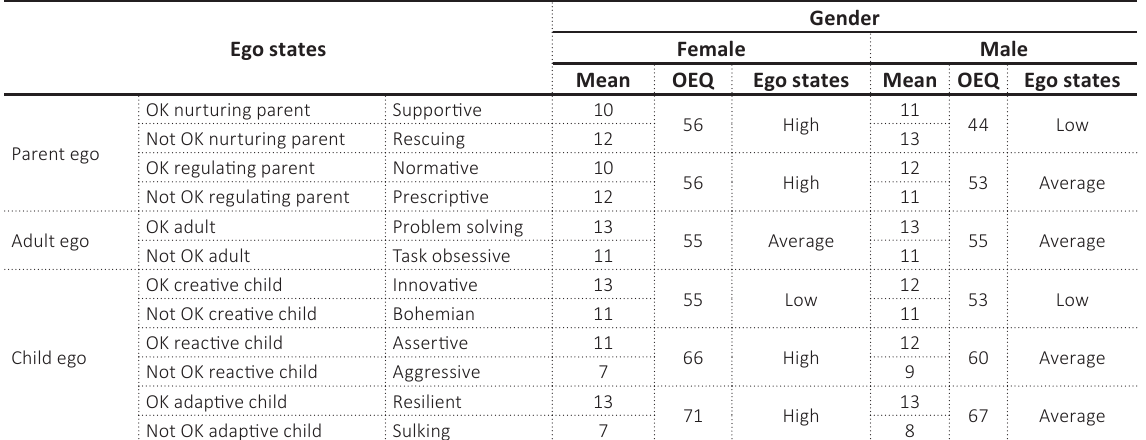
Table 2. Level of ego states based on gender